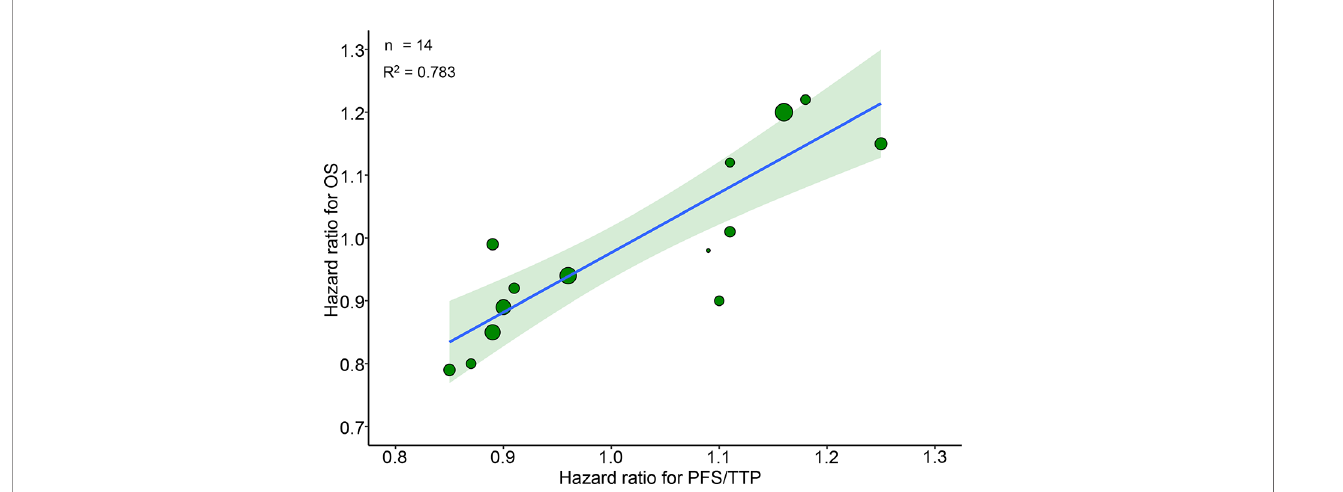
FIGURE 1 | Trial-level correlation between hazard ratios for OS and PFS/TTP in phase III RCTs. Green circles represent trials with a size proportional to the number of patients, blue line for the estimated regression line and the light green zone for 95% con fi dence intervals. OS, overall survival; PFS/TTP, progression free survival/ time to progression; RCTs, randomized controlled trials.